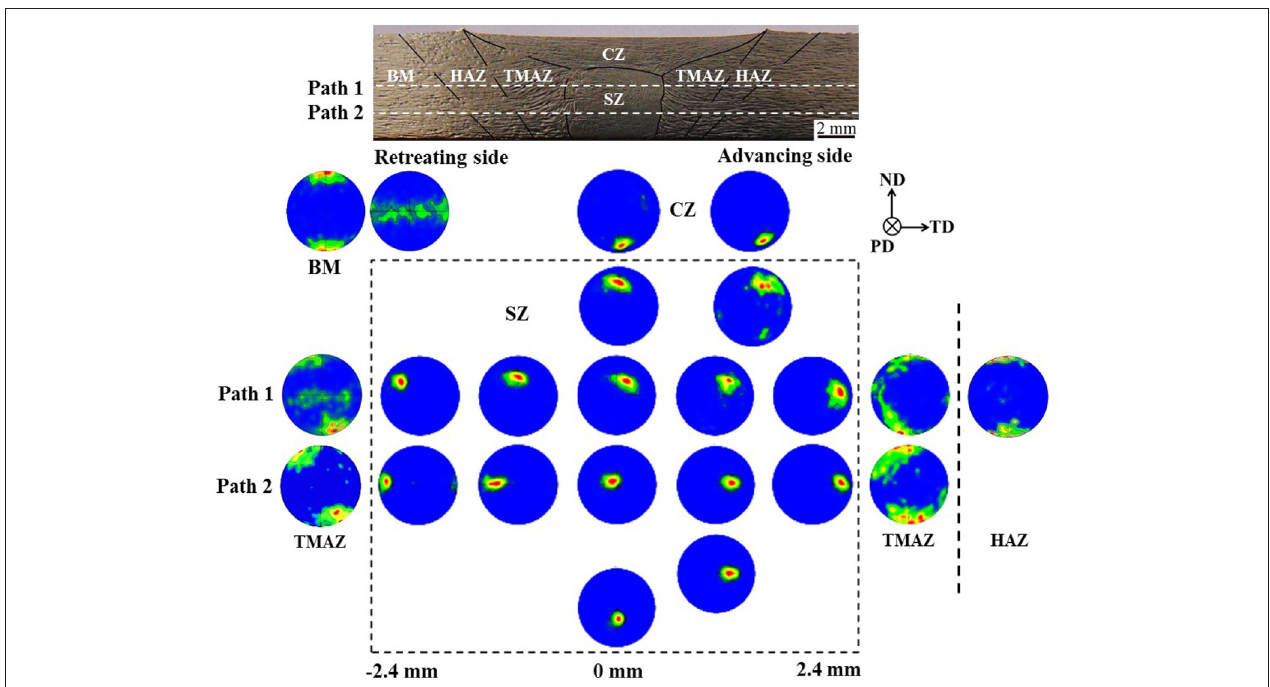
FIGURE 2 | Overall cross-sectional macrostructure of the FSP AZ31Mg alloy and the {0002} pole figures in various regions of the joint (Xin et al., 2010) (Copyright © 2010, Trans Tech Publications Ltd.).